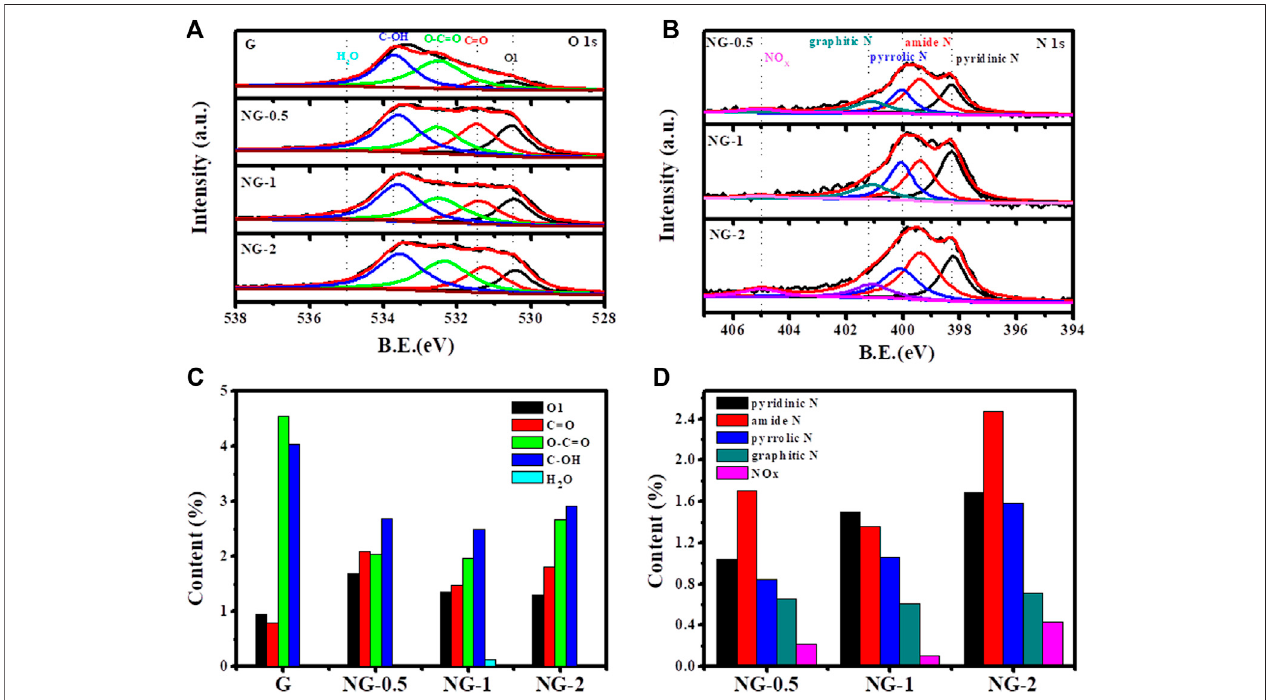
FIGURE 3 | High resolution O 1s (A) and N 1s (B) XPS of graphene monolith; content of different O species (C) and N species (D) in graphene monolith samples from XPS and corresponding deconvolution results.